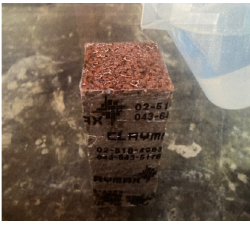
Figure 1. Measurement of porosity.